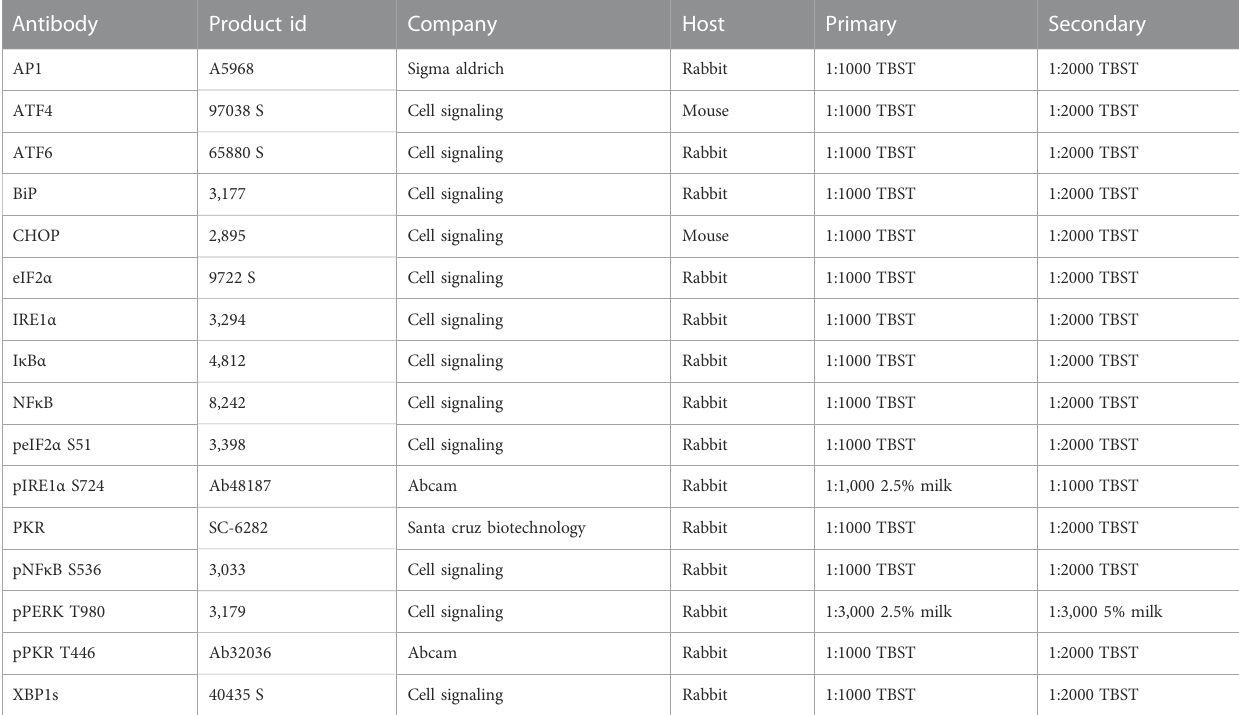
TABLE 1 Primary and secondary antibodies used for Western blotting.